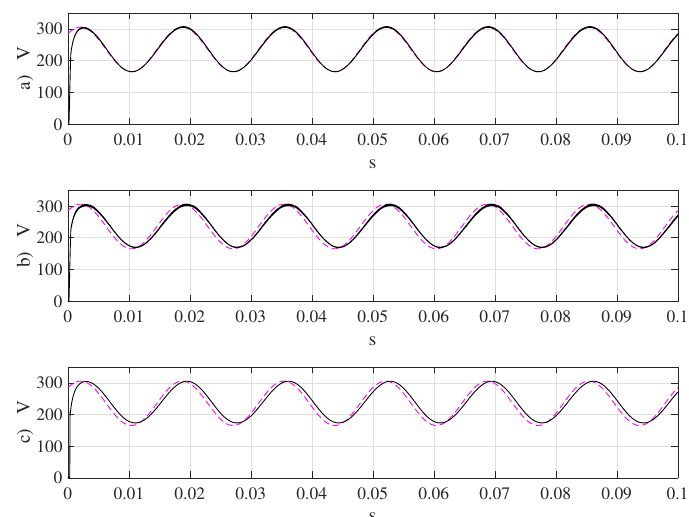
Figure 2. Output tracking of the capacitor voltage. Reference signal in dashed line, and capacitor voltage in solid line. ( a ) Proposed controller. ( b ) Controller in [8]. ( c ) Controller in [40].